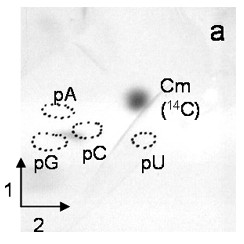
Nuclease P1 cleavage of total tRNA from yfhQ K.O. strain incubated with YfhQ and AdoMet. Autoradiography of a two-dimensional chromatogram of 5'-phosphate nucleosides on a thin layer cellulose plate. The reaction mixture containing 50 mM PIPES-Na, pH 7.0, 4 mM MgCl2, 100 μg of total tRNA from yfhQ K.O. strain, 5 μg of the purified YfhQ protein, and 10 μM [14C-methyl]AdoMet (53 mCi/mmol). After 60 min incubation at 37°C, the tRNA was recovered, digested by nuclease P1 and the resulting nucleotides were analyzed as described [38].